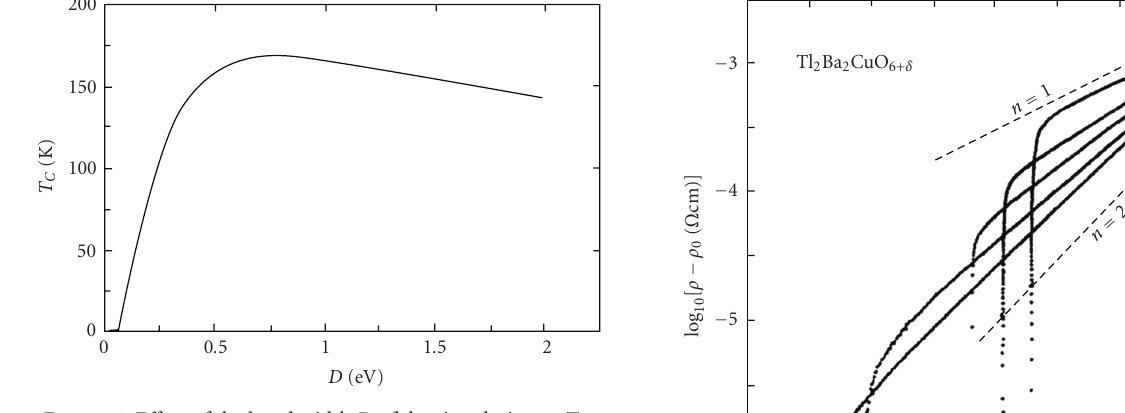
Figure 4: E ff ect of the band width D of the singularity on T C .